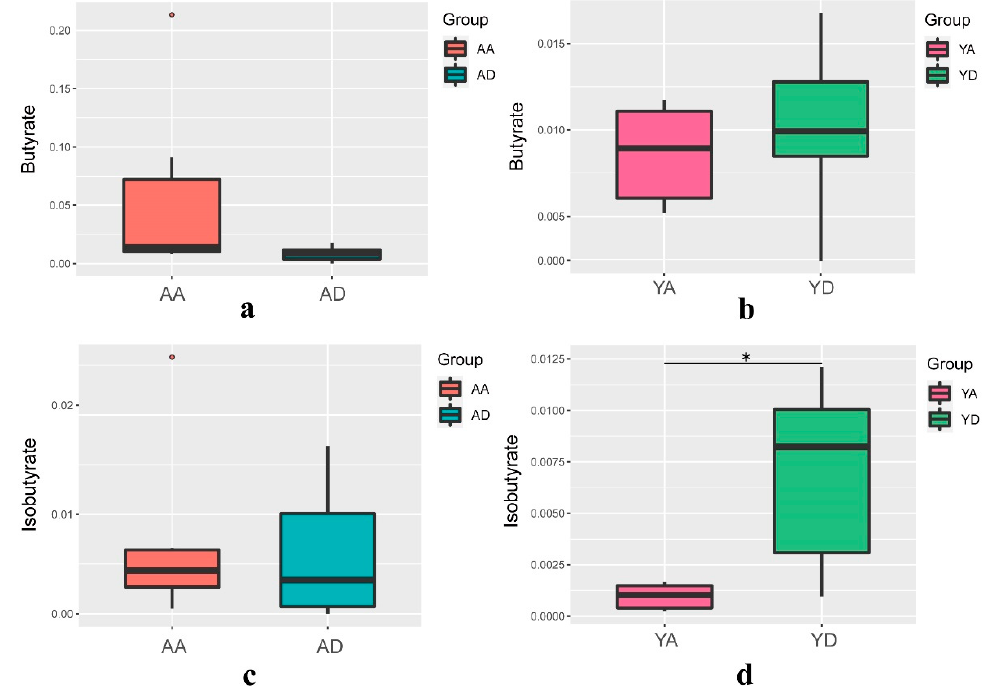
Figure 7. Determination of butyric acid and isobutyric acid in fecal samples during 21 days by GC-MS. ( a ) Changes in butyrate levels in the placebo group; ( b ) Changes in butyrate levels in the probiotics group; ( c ) Changes in isobutyric acid levels in the placebo group; ( d ) Changes in isobutyric acid levels in the probiotics group. (AA and AD represent the 0-day and 21-day placebo groups, respectively; YA and YD represent the 0-day and 6-day probiotic groups, respectively.)